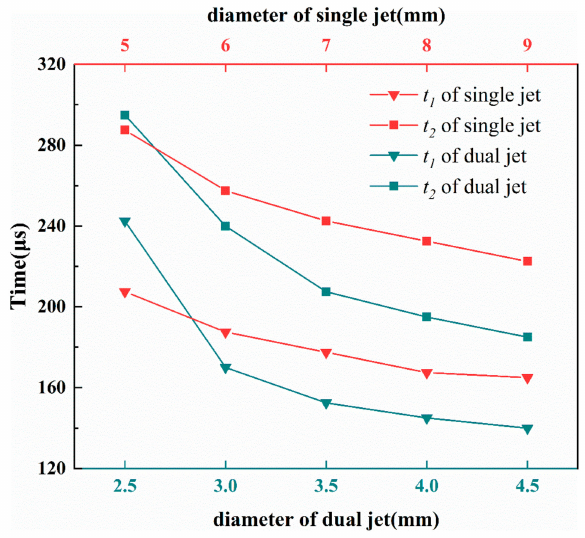
Figure 14. Two critical initiation times for different jet diameters based on two initiation methods. The upper and lower horizontal coordinates correspond to the same total jet